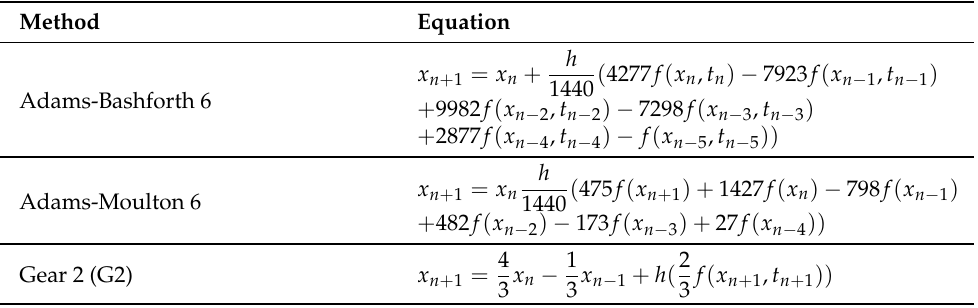
Table 2. Multi-step